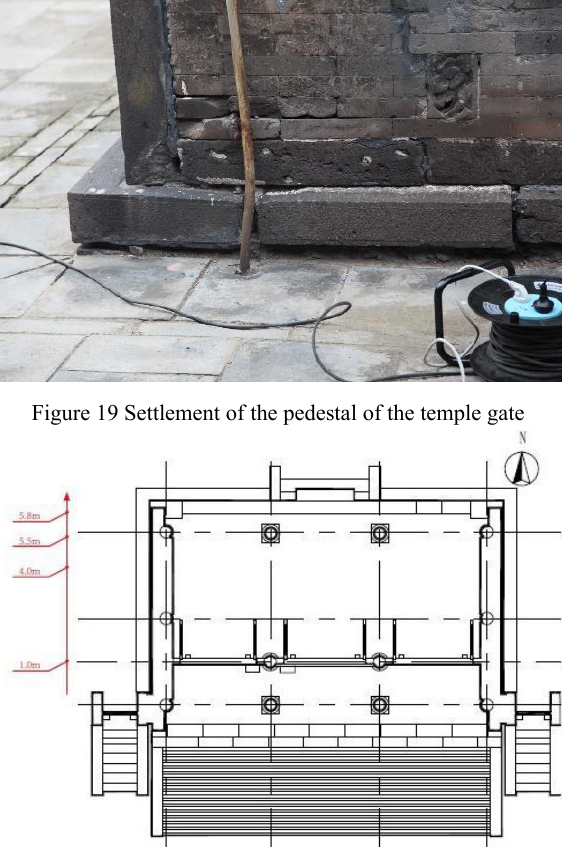
Figure 20 Plan sketch of the temple